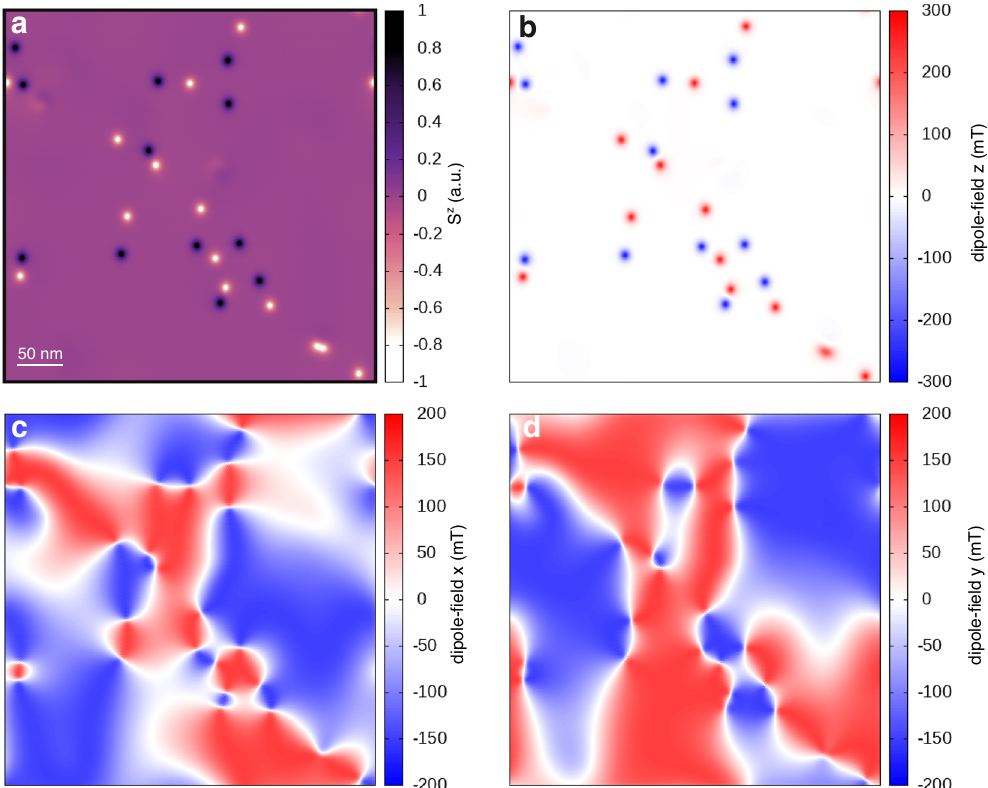
Fig. 4 Dipolar interactions driven the formation of merons and antimerons. a Snapshot of one of the spin dynamics at 0 K and zero magnetic fi eld showing the out-of-plane spin component S z (color map) throughout the surface of monolayer CrCl 3 . b – d Projection of the dipole – dipole interactions along of z , x , and y directions, respectively, on the snapshot in a . The dipole fi elds are quanti fi ed in mT with positive (red) and negative (blue) magnitudes in the color scale. The scale bar of 50 nm is common to all